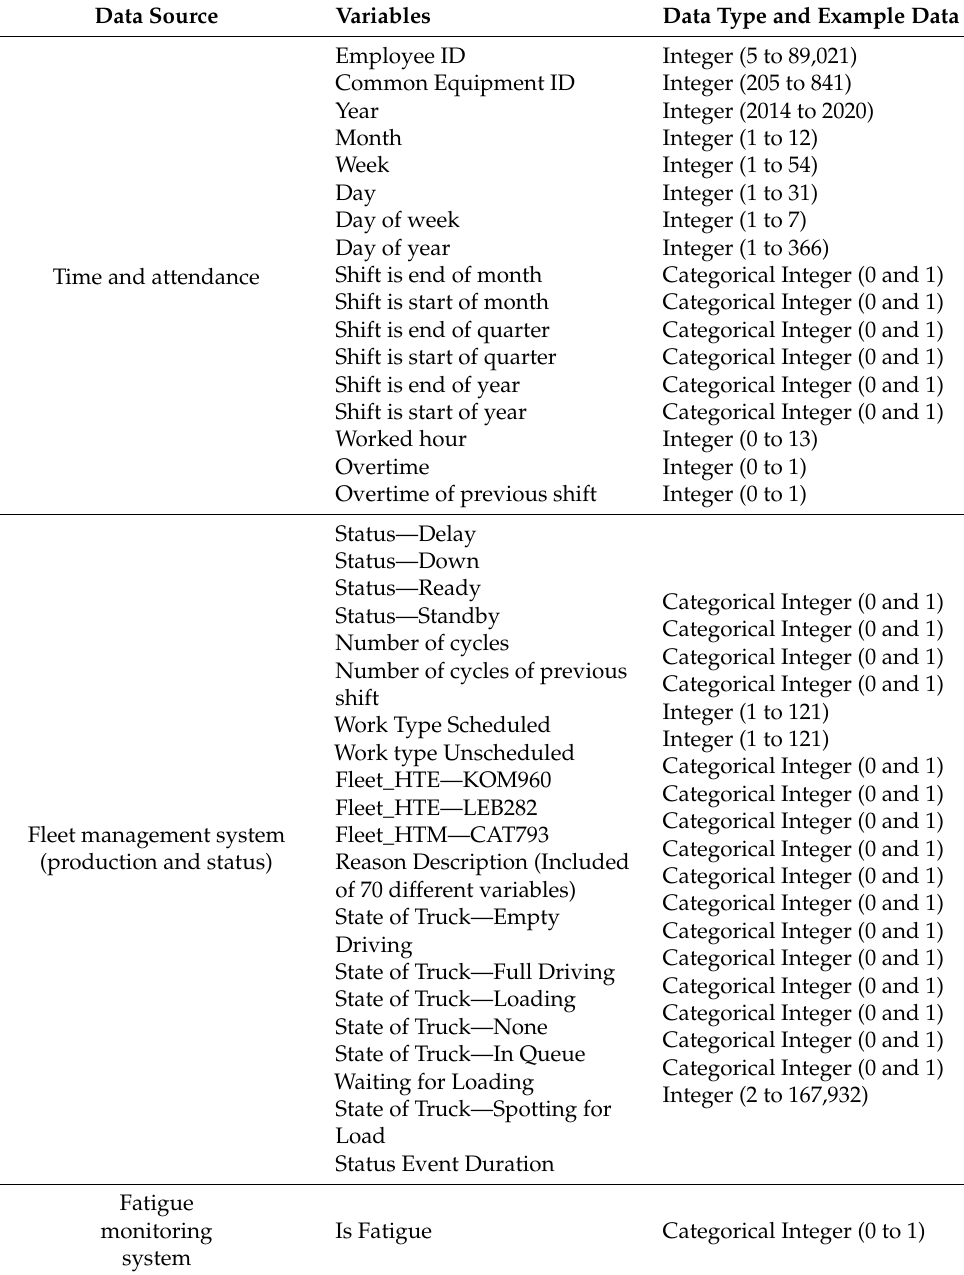
Table 3. List of the variables based on the data